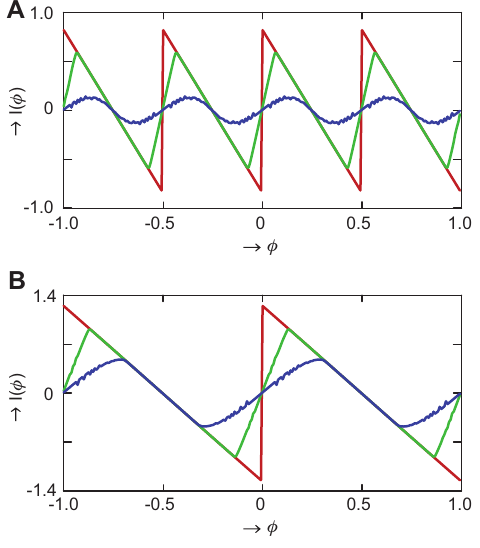
Figure 5 Drude weight as a function of Hubbard interaction strength U for single-channel mesoscopic rings. (A) Half-fi lled case. The red, green, and blue curves correspond to N = 10, 30, and 50, respectively. (B) Non-half-fi lled case with N = 20. The red, green, and = 10, 14, and 18, blue curves correspond to N e